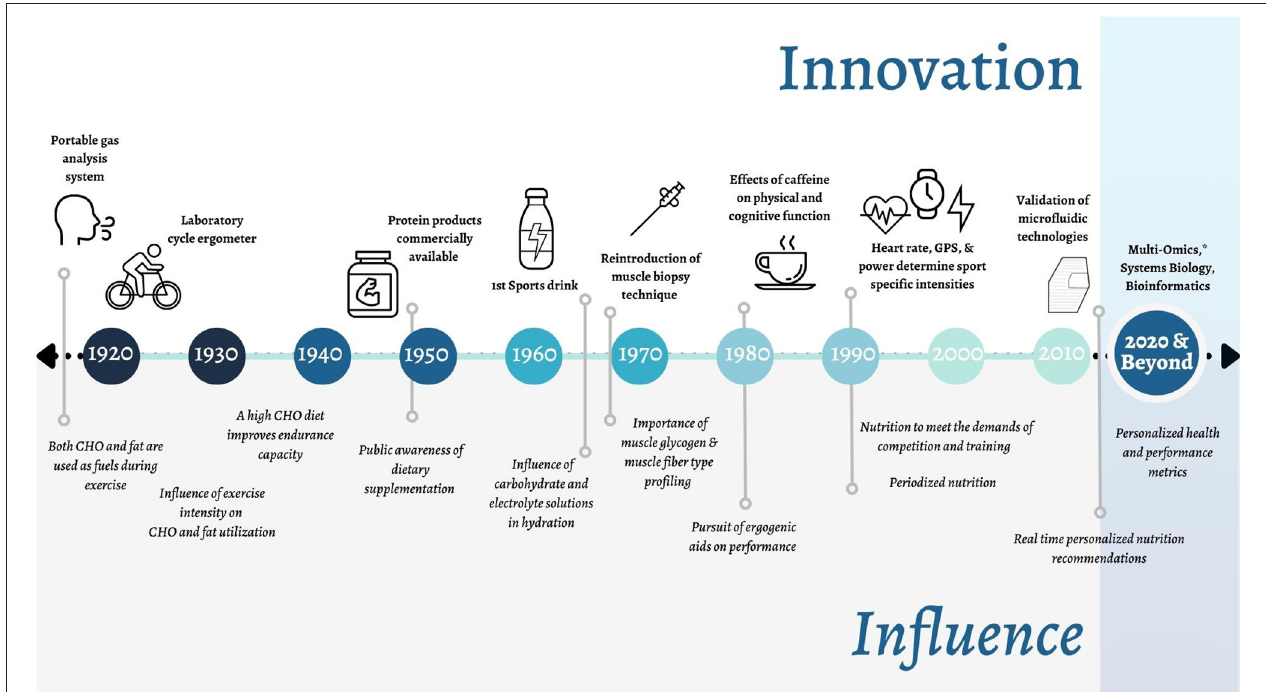
FIGURE 2 | Timeline of key innovations in Sports Nutrition and their respective influence on the field. *Including: genomics, transcriptomics, metabolomics, proteomics, phenomics, and other related omics (e.g., epigenomics).